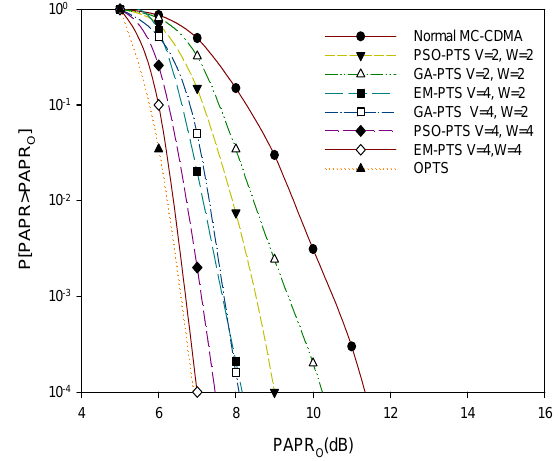
Fig. 6 Comparison of the PAPR CCDF of several PTS methods.